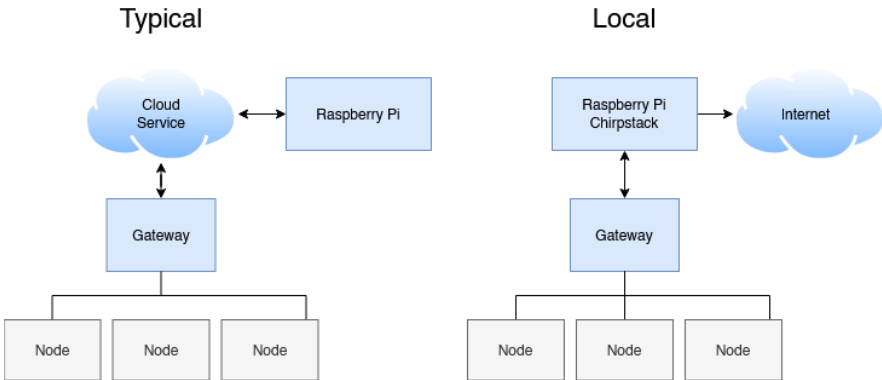
Figure 4. Comparison of the typical LoRaWAN system and prototype hospital bed node system.